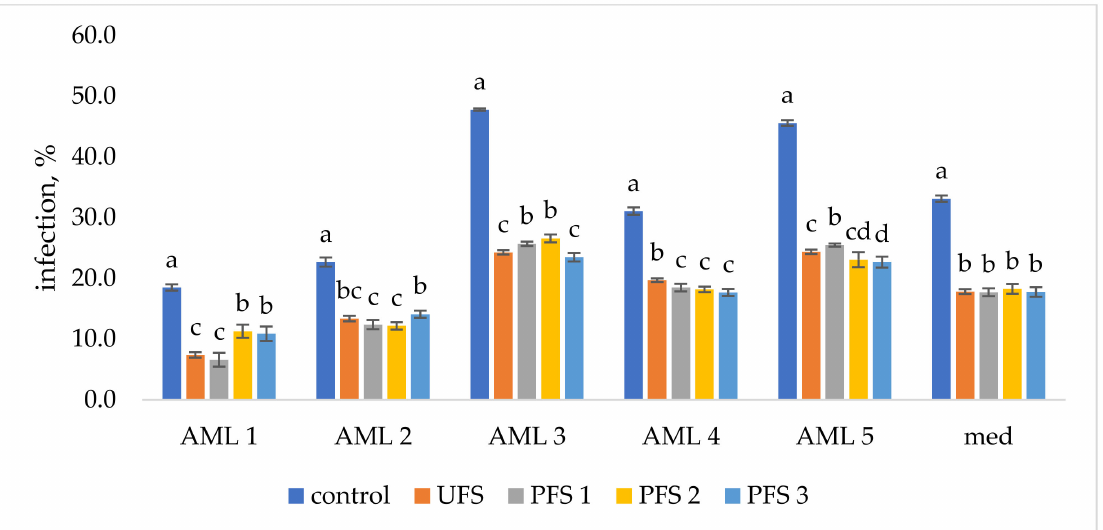
Figure 7. Oat infection with red-brown spot pathogen. The different letters represent statistically sig- nificant ( p ≤ 0.05) differences between the tested options of fertilizer application. Error bars show the standard deviation of the mean value ( n = 15). AML 1 is the eluvial agricultural microlandscape,